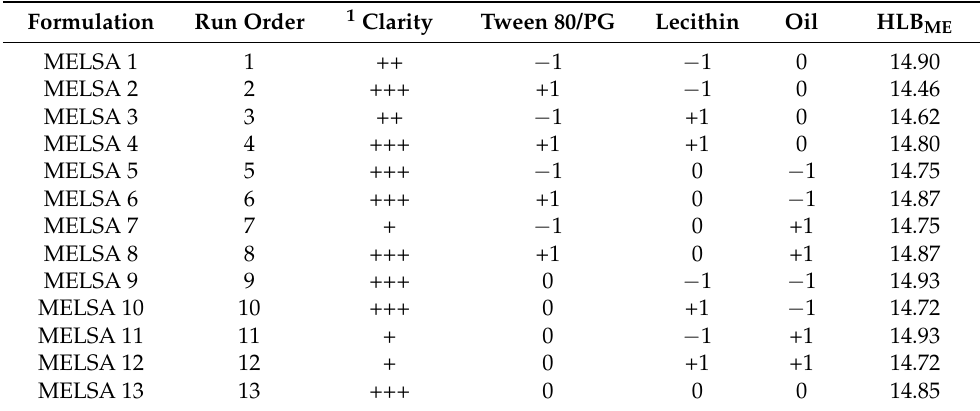
Table 3. Experimental matrix of microemulsions MELSA 1–MELSA 13.